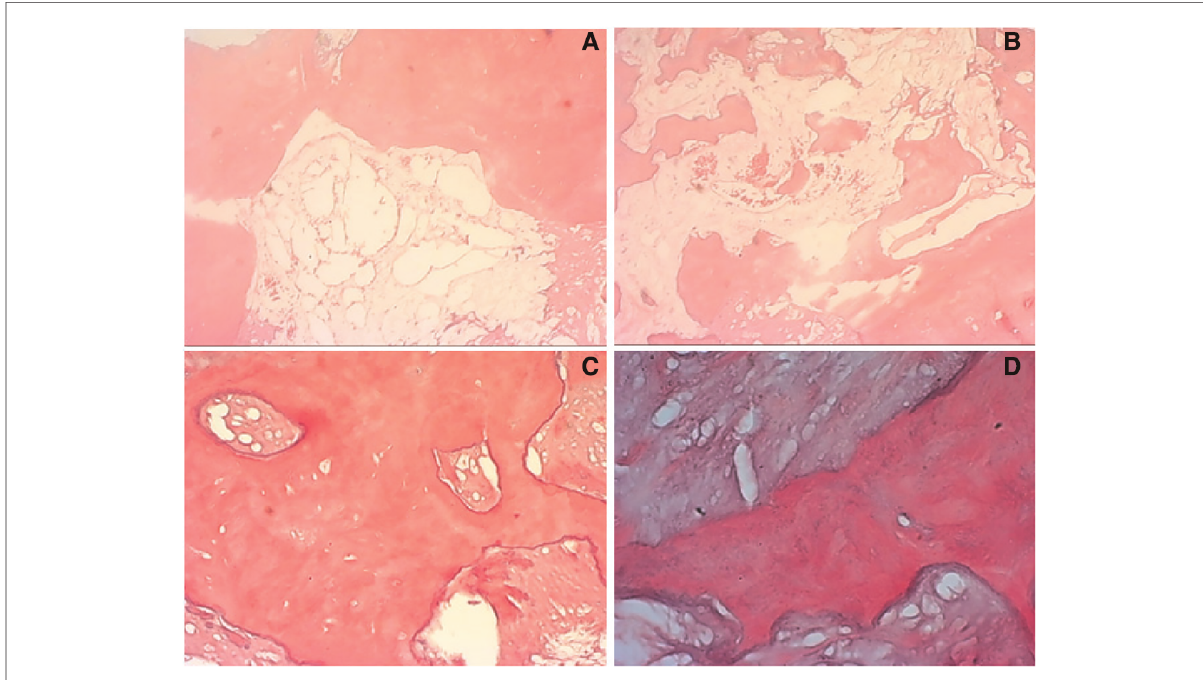
FIGURE 4 In some typical microscopic images, myxoid degeneration, calci fi ed bone tissue, fat necrosis, cystic degeneration, irregular calci fi cation, and collagen degeneration of fi brous tissue are seen (original magni fi cations of ×4 in ( A,B , ×10 in ( C ), ×40 in D